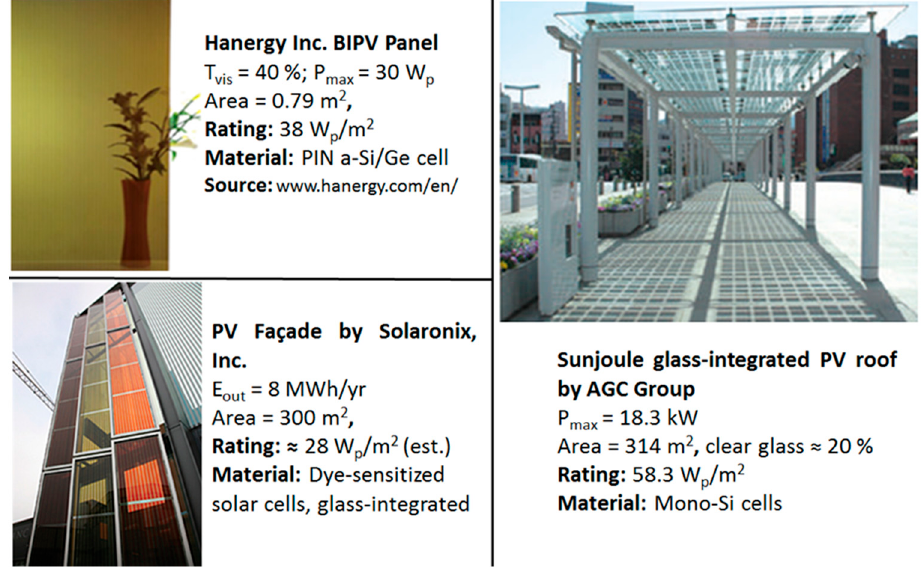
Figure 1. Commercial solar window technology examples [10,11,19] and their reported (or estimated) metrics in terms of energy-output characteristics.